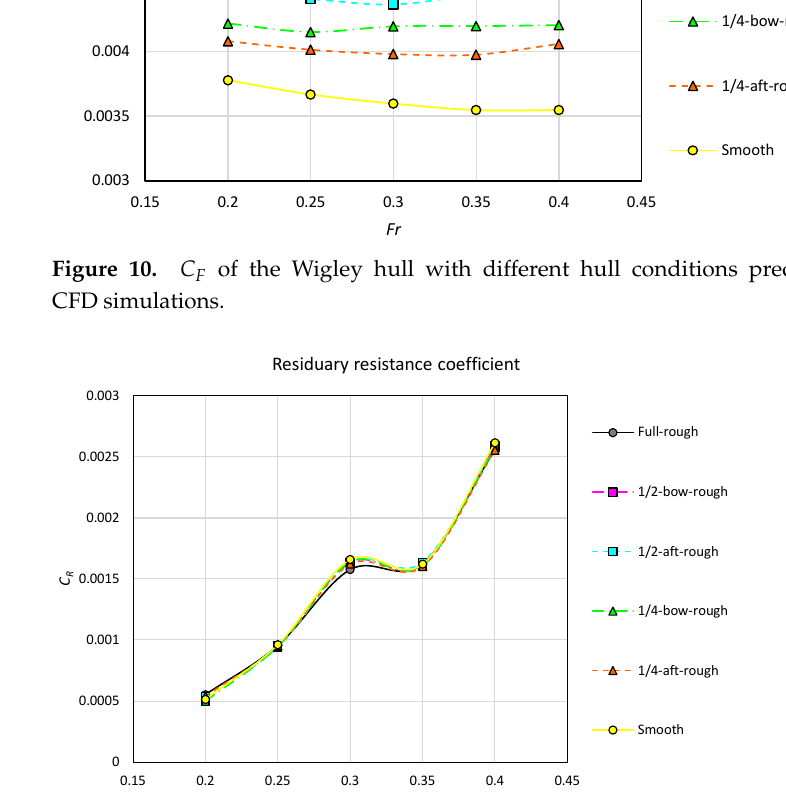
Figure 11. C R of the Wigley hull with different hull conditions predicted from the current CFD simulations.